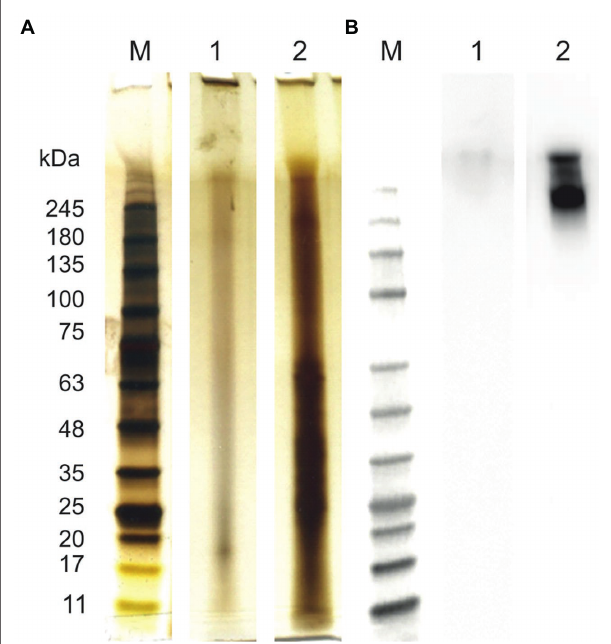
FIGURE 1 | Protein characterization of arabinogalactan protein (AGP)-like enriched fraction (AGPs) and ulvan. Samples were analyzed using SDS-PAGE and silver staininig (A) and immunolabeling with anti-AGP JIM16 primary antibody, 10 s exposition time (B) . (1) Ulvan; (2) AGPs. For the SDS-PAGE separation were used 4%–15% gradient precast polyacrylamide gels. Prestained Protein Ladder—Broad molecular weight (10–245 kDa, ab116028) was